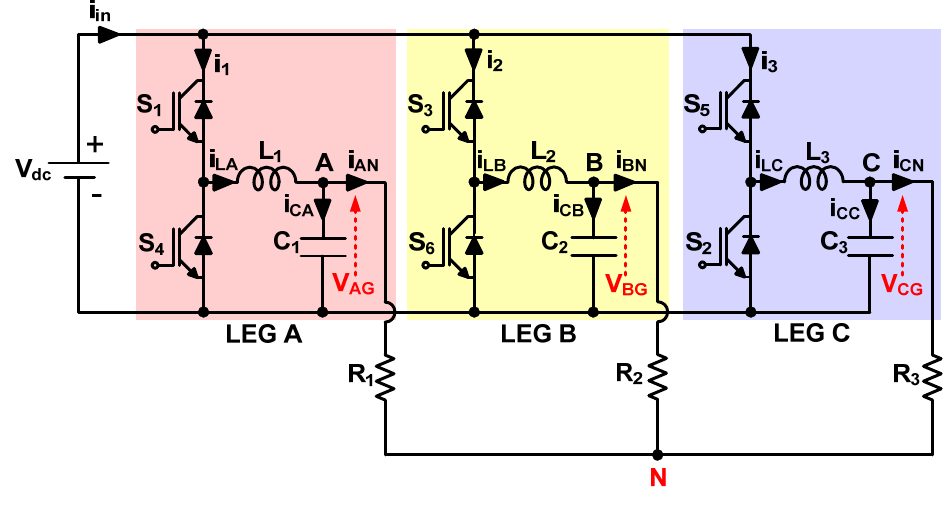
Figure 1. TPRBI: circuit with resistive load.